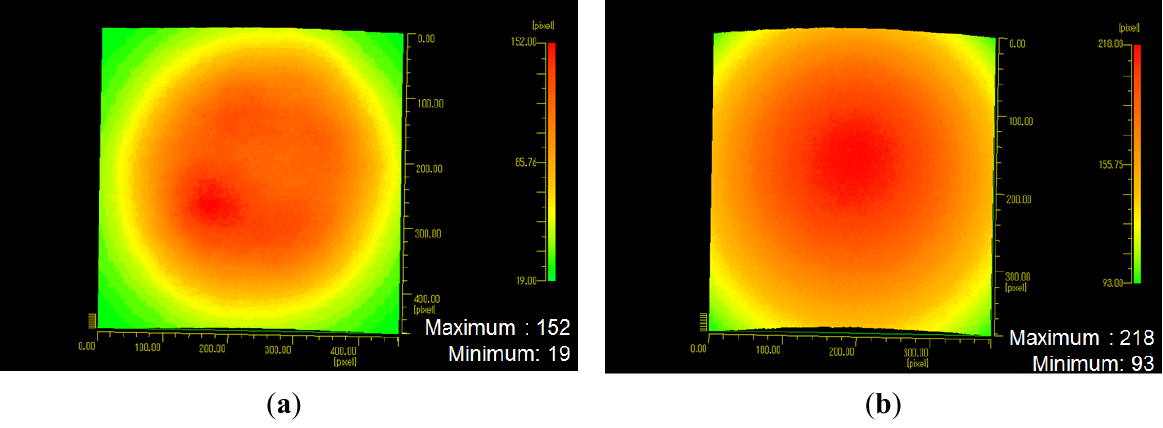
Figure 1. Brightness distribution by using whiteboard for different types of lighting system. ( a ) Ring light; ( b ) Dome